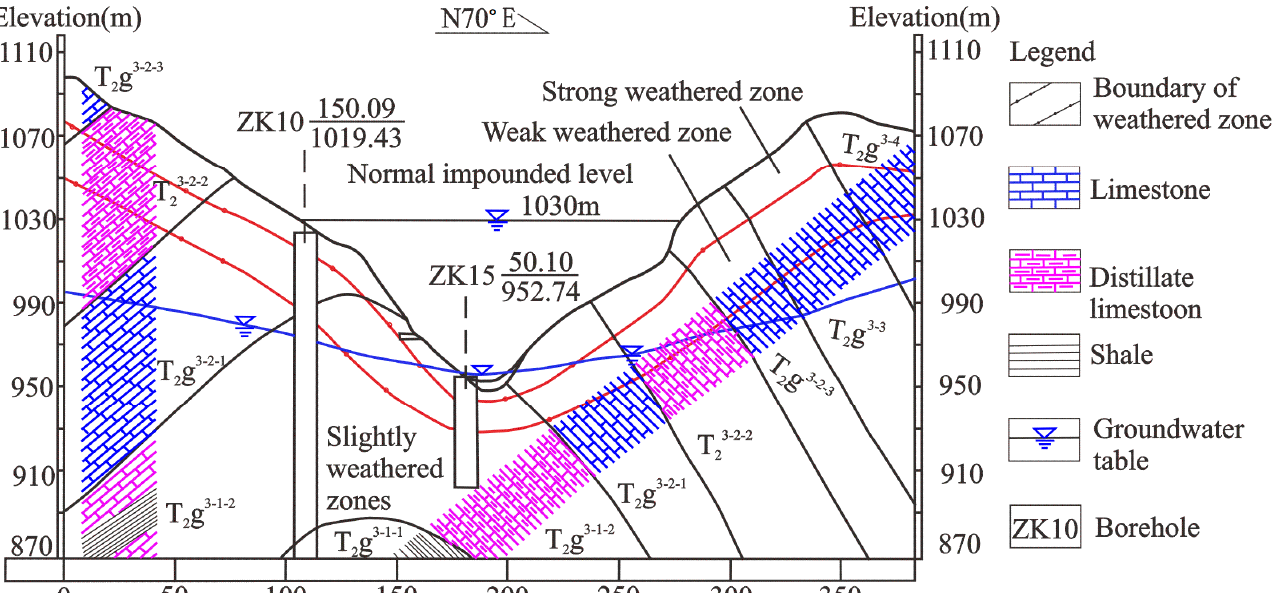
Table 1. Percentage of Lu values for different weathering zones (%).